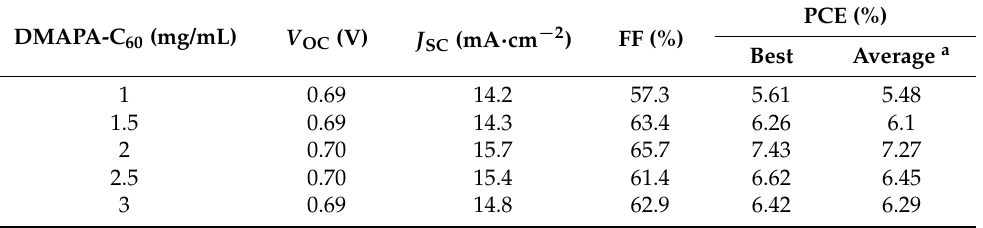
Table 1. Device performances of OSCs based on DMAPA-C 60 with different DMAPA-C 60 concentrations.